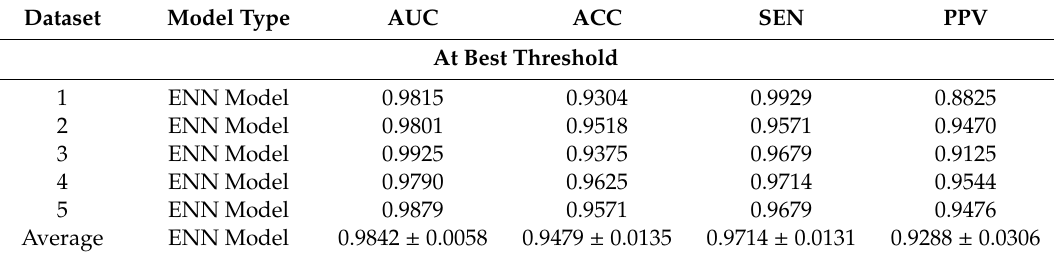
Table 3. The ROC curve analyses by test dataset for ENN models.